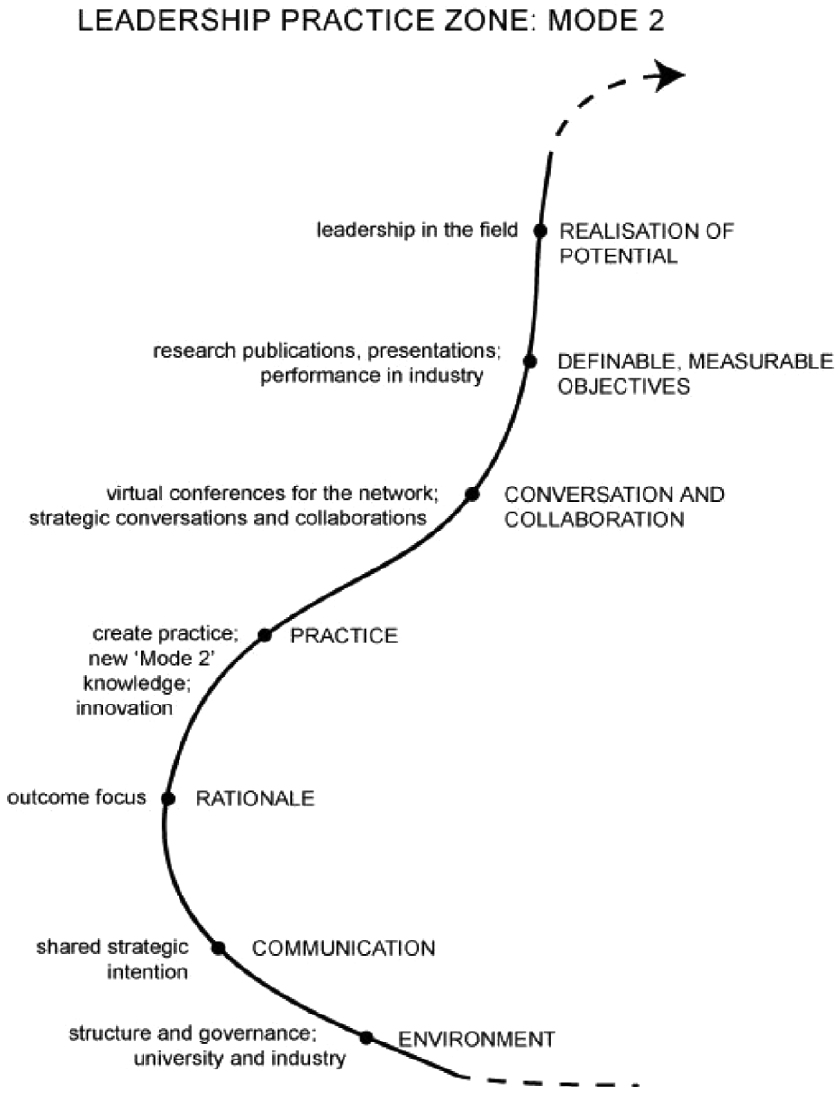
Figure 3. Action pathway of seven steps in the leadership zone to develop Mode 2